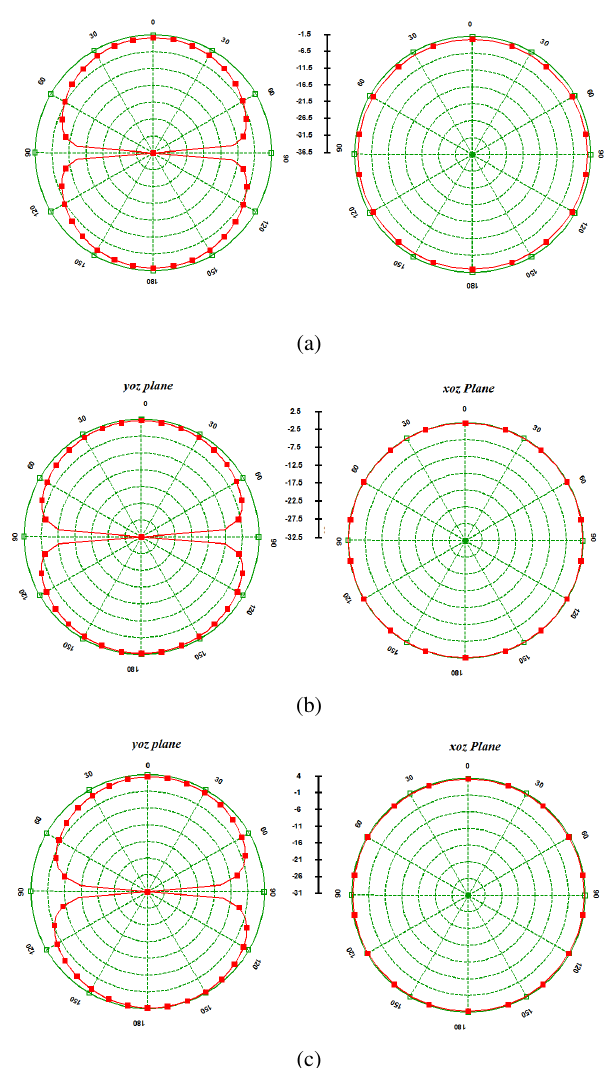
Figure 6: Radiation patterns at: (a) 2.43 GHz, (b) 3.5 GHz and, (c) 5.8 GHz